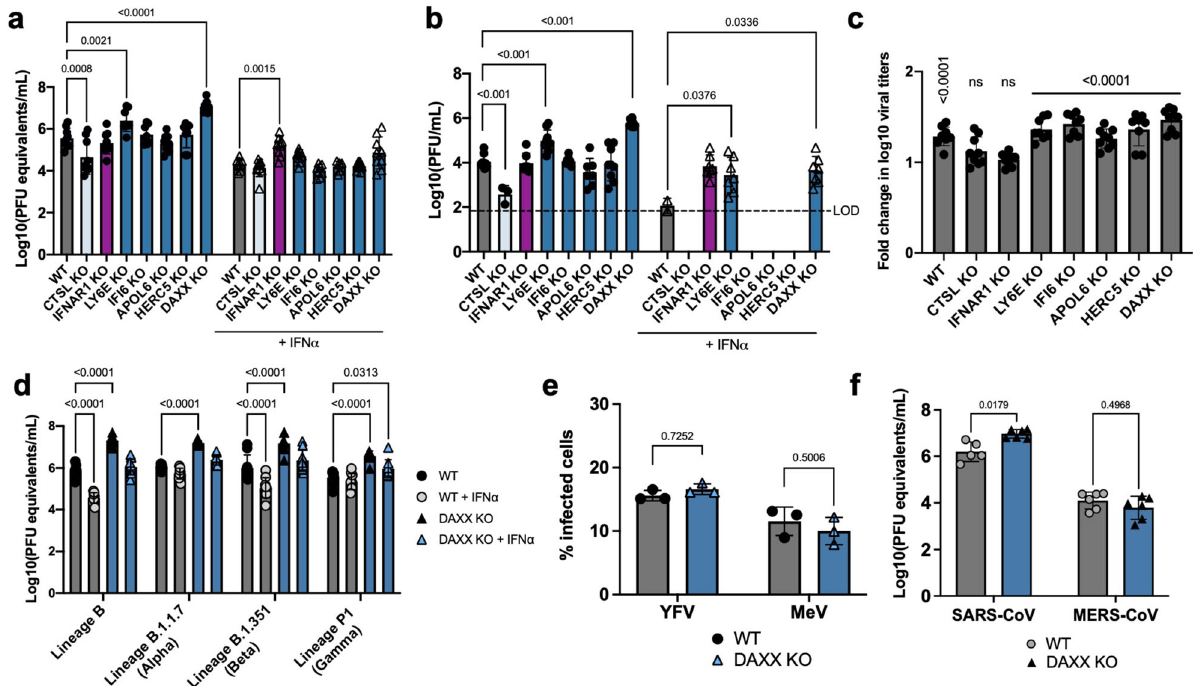
Fig. 2 DAXX is a restriction factor for SARS-CoV-2. a – c Antiviral activity of ISGs against SARS-CoV-2. A549-ACE2 knocked-out for the indicated genes were generated using a multi-guide approach, leading to pools of KO cells with a high frequency of indels. KO cells were pre-treated with 0 (circles) or 200 (triangles) U/mL of IFN α 24h prior to infection with SARS-CoV-2 (at an MOI of 0.1). Supernatants were harvested at 72h p.i. The mean ±SD of three independent experiments, each performed in three biological replicates, is shown. a For the titration of RNA levels, supernatants were heat-inactivated prior to quanti fi cation by qRT-PCR. Genome copies/mL were calculated by performing serial dilutions of a synthetic RNA with a known concentration. Statistics: 2-way ANOVA using Dunnett ’ s test. Signi fi cant p values (below 0.05) are indicated on the graph. b For the titration of infectious virus levels by plaque assay, supernatants were serially diluted and used to infect VeroE6 cells. Plaques formed after 3 days of infection were quanti fi ed using crystal violet coloration. The limit of detection (LOD) is indicated as a dotted line. Statistics: Dunnett ’ s test on a linear model, (two-sided). Signi fi cant p values (below 0.05) are indicated on the graph. c For each of the indicated KO, the data shown in ( a ) is represented as fold change in log10 titers (i.e. the log10 titers of the non- treated condition divided by the mean of the triplicate log10 titers IFN α -treated condition, n = 3). Statistics: 2-way ANOVA using Sidak ’ s test. P values are indicated on the graph (ns: p value> 0.05). d – f Antiviral activity of DAXX against SARS-CoV-2 variants and other viruses. d A549-ACE2 WT or DAXX KO cells were infected at an MOI of 0.1 with the following SARS-CoV-2 strains: Lineage B (original strain); Lineage B.1.1.7. (Alpha variant);